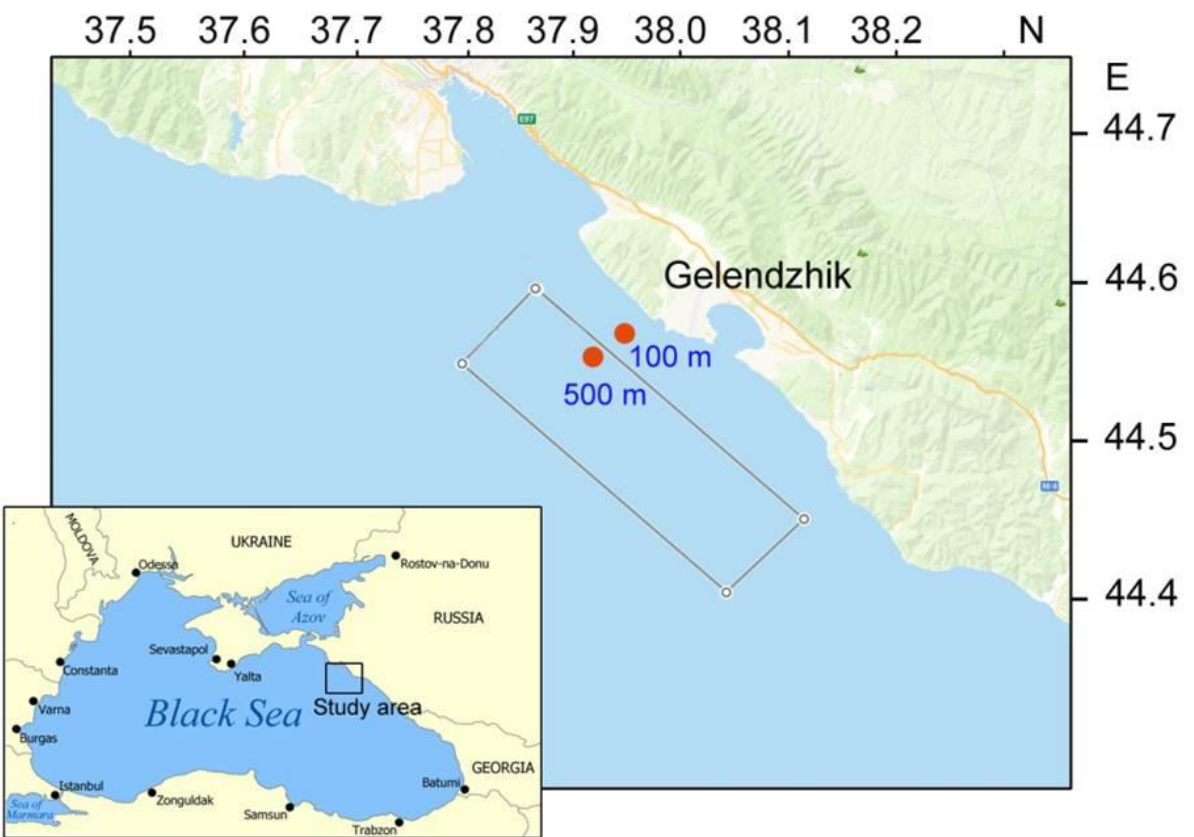
Figure 1. Map of the study area. The dots show the locations of two stations at 100 m and 500 m. The rectangle shows the area for the satellite scanner’s estimates of chlorophyll-a